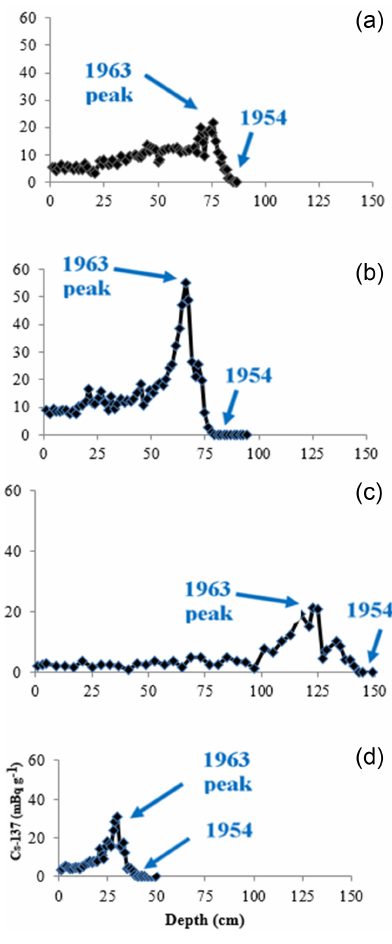
Figure 3. 137 Cs profiles; (a) , Furnace Pond; (b) , Hammer Pond; (c) , Lurgashall Mill Pond and (d) , Inholms